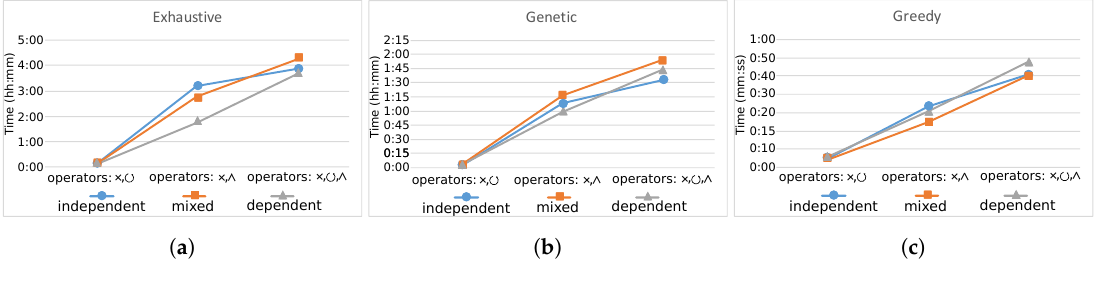
Figure 19. Performance of the different strategies when varying the model complexity. ( a ) Exhaustive; ( b ) genetic; ( c ) greedy. Table 9. Results obtained for all strategies considering different model